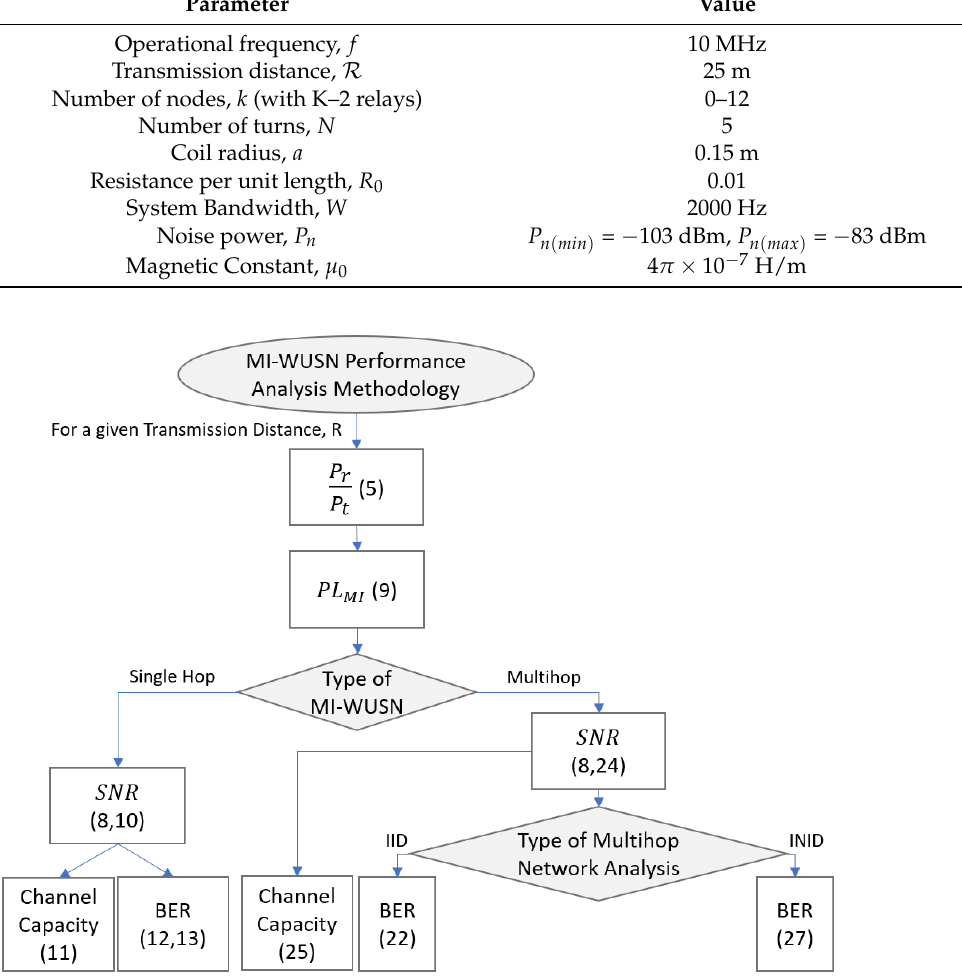
Figure 4. Performance analysis methodology of multihop underground magnetic induction com- munication system in terms of SNR, channel capacity and BER. For a given transmission distance, performance evaluation has been carried out for three types of networks: (1) single hop, (2) multihop with independent and identical distribution (IID) of hop states, and (3) multihop with independent and non-identical distribution (INID) of hop states.